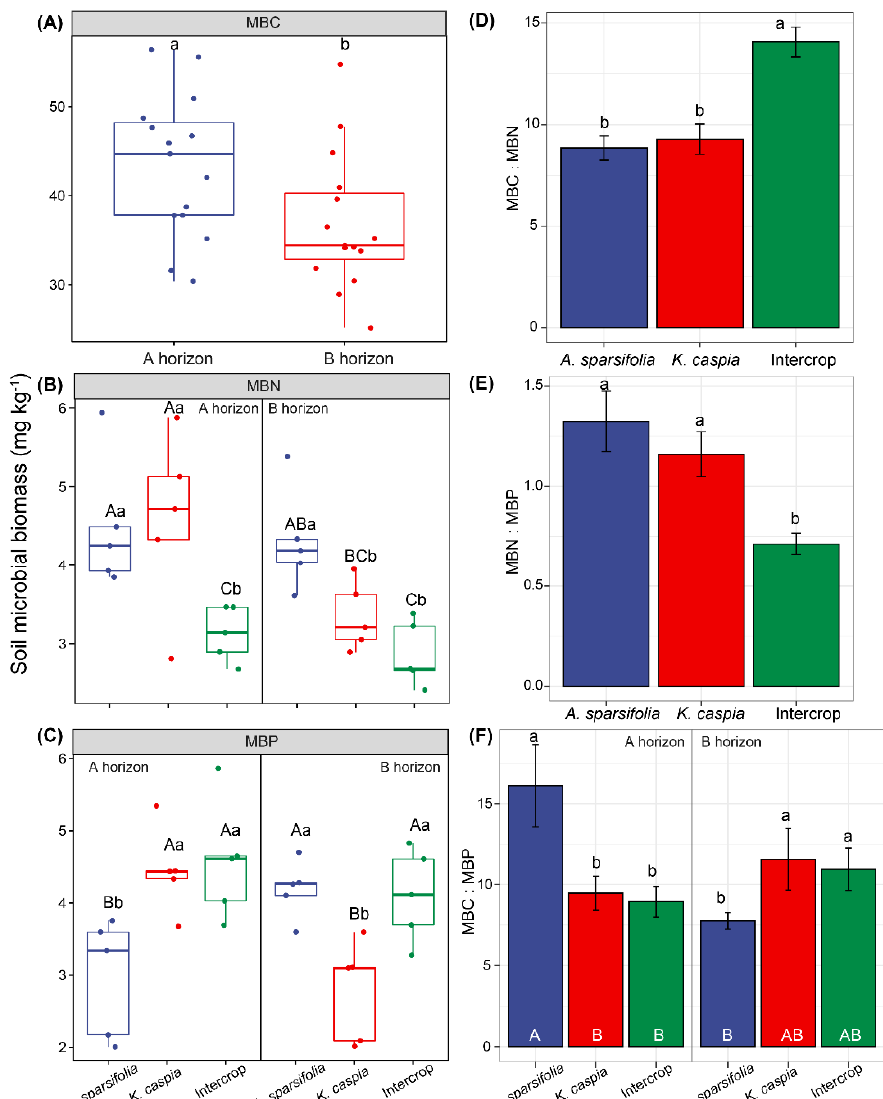
Figure 2. Effects of soil horizon(A or B; depth) and plant community ( Alhagi sparsifolia (legume) monoculture, Karelinia caspia (non-legume) monoculture, or both species intercropped)on ( A ) soil microbial biomass C (carbon), ( B ) microbial biomass N (nitrogen), ( C ) microbial biomass P (phosphorus), ( D ) microbial biomass C:N, ( E ) microbial biomass N:P, and ( F ) microbial biomass C:P. Values are means ± SE. Different capital letters indicate significant differences at p < 0.05 among six treatments, and lowercase letters above error bars indicate significant differences at p < 0.05 among different plant communities and soil horizons, or among different plant communities within each soil layer.